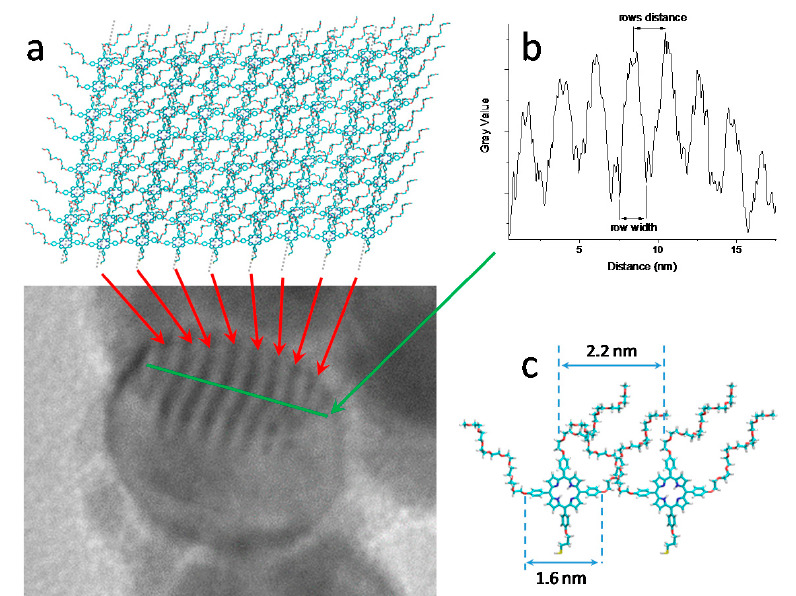
Figure 7. Simulated molecular nanopatterning of P(PEG350) 3 bonded on AgNPs surface ( a , top); magnification of AgNP@P(PEG350) 3 TEM image ( a , bottom); rows profile estimated in the green line path ( b ); MM + molecular modeling simulations of nanostructured P(PEG350) 3 ( c ).